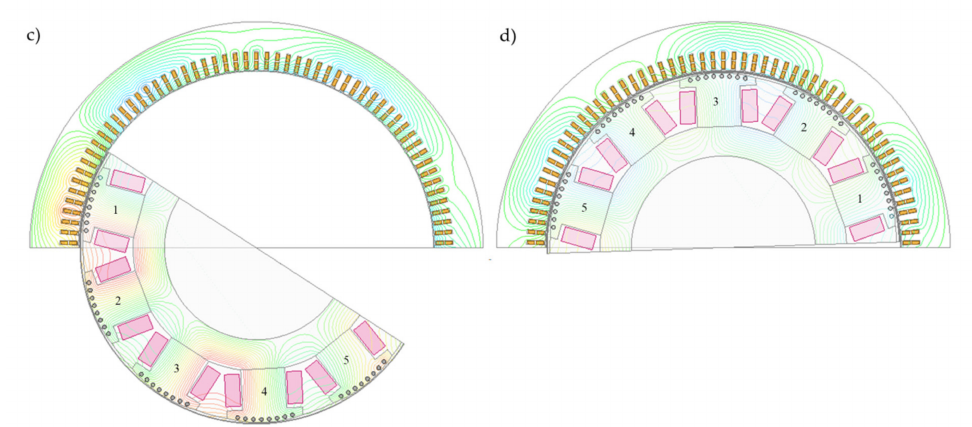
Figure 22. Magnetic field lines during out-of-phase synchronization of − 120 ◦ at ( a ) 0.02 s, ( b ) 0.025 s, ( c ) 0.03 s, and ( d ) 0.302 s.